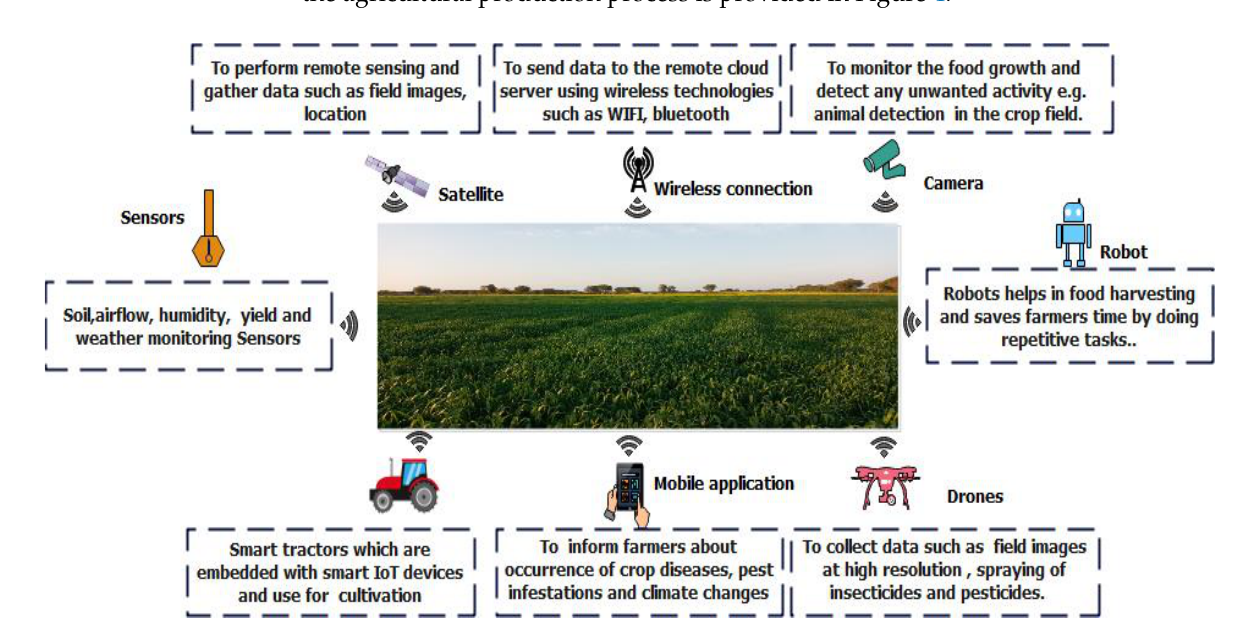
Figure 4. ICT tools used in agricultural production process.